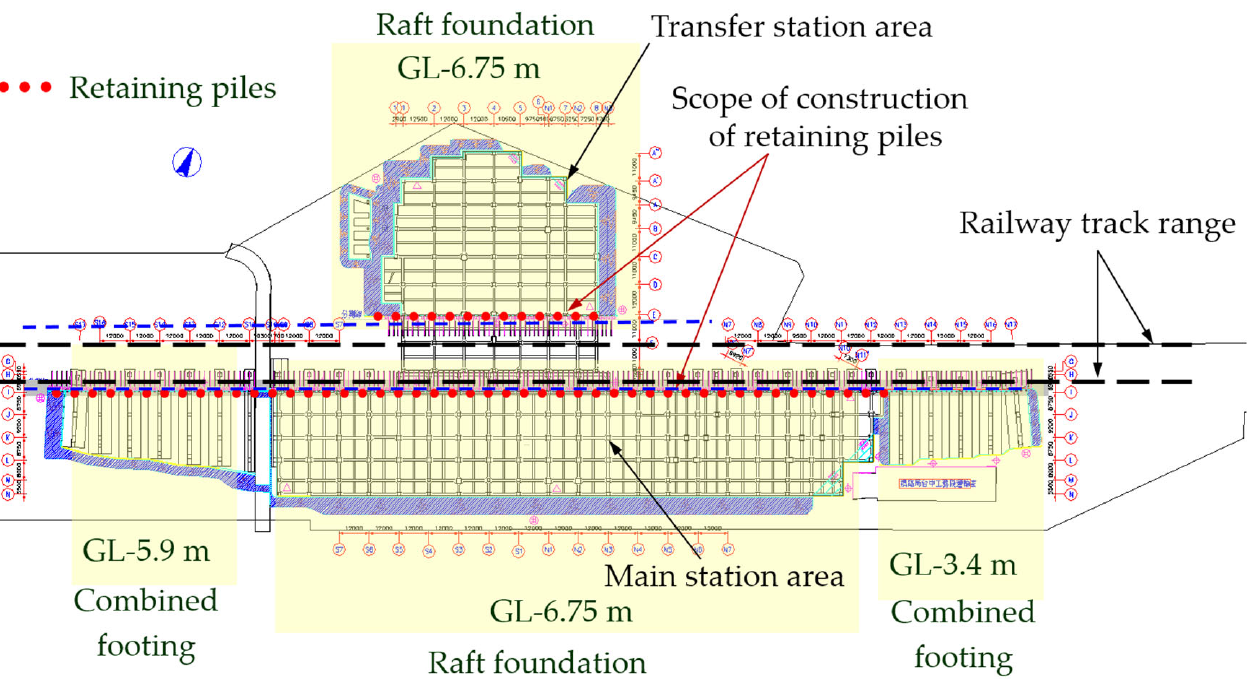
Figure 1. Scheme of the excavation and support system of Taichung Station.